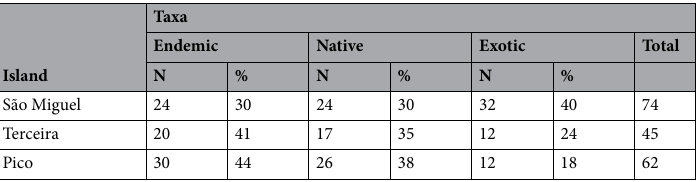
Table 1. Plant species richness at the three types of forests sampled on three islands in the Azores archipelago. Endemic taxa only occurring in the Azores; Native taxa that colonized the Azores without human intervention, also occurring in other regions; and Exotic taxa that were intentionally or accidentally introduced by human activities 59 .